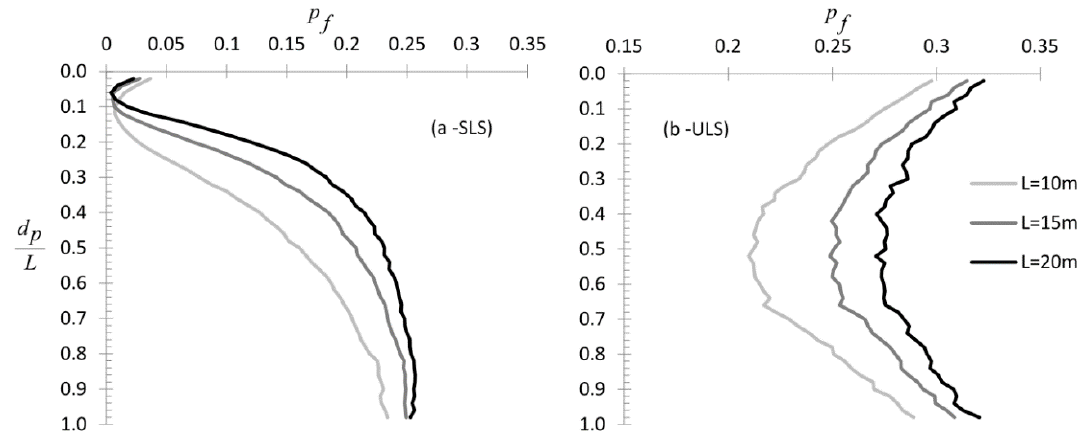
ff erent pile lengths